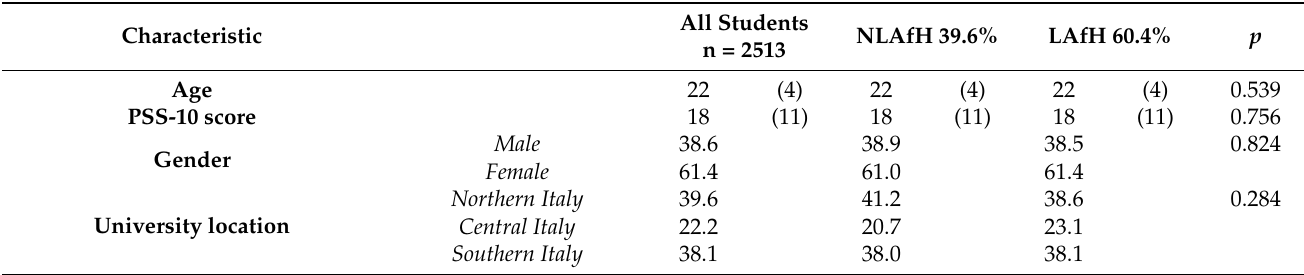
Table 1. Characteristics of the